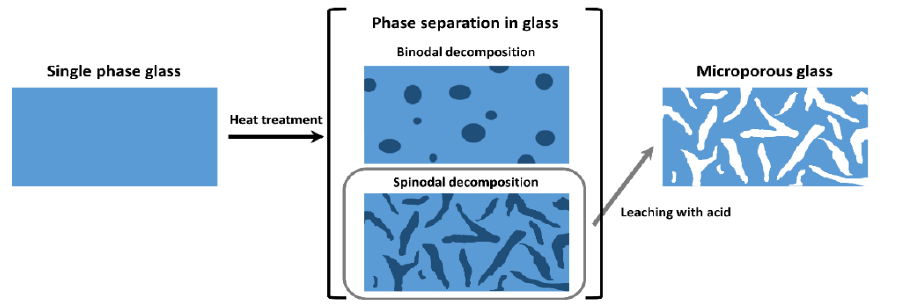
Figure 2. Schematic diagram of how to create porous glass using phase separation in glass obtained from slag. Recreated from [65].